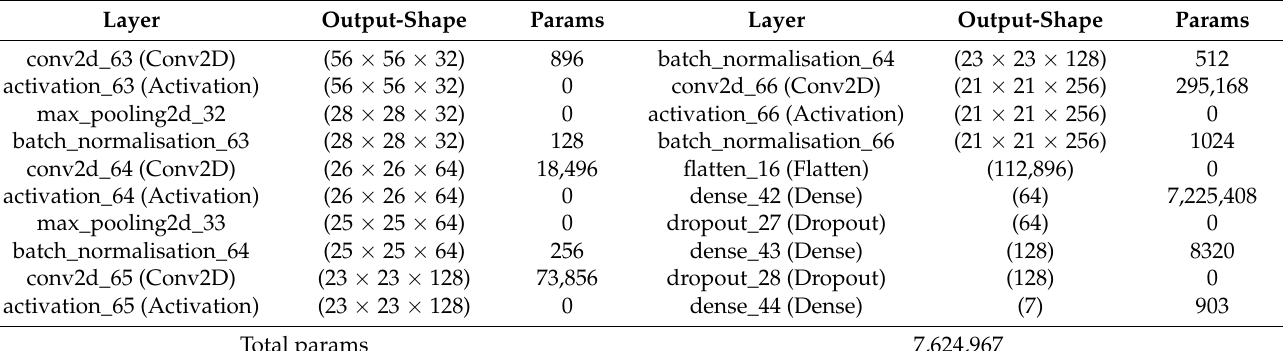
Table 1. The internal architecture of the proposed